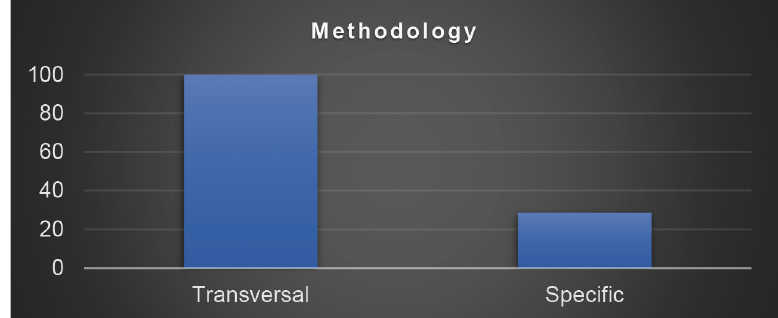
Figure 4. The methodology followed in the implementation of the project